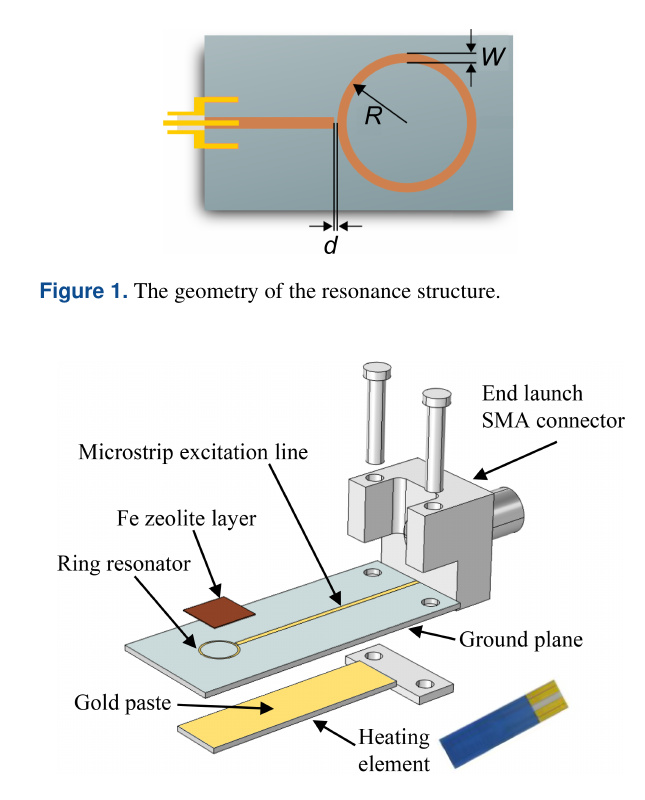
Figure 2. Schematic design of the planar and heatable resonance sensor for ammonia